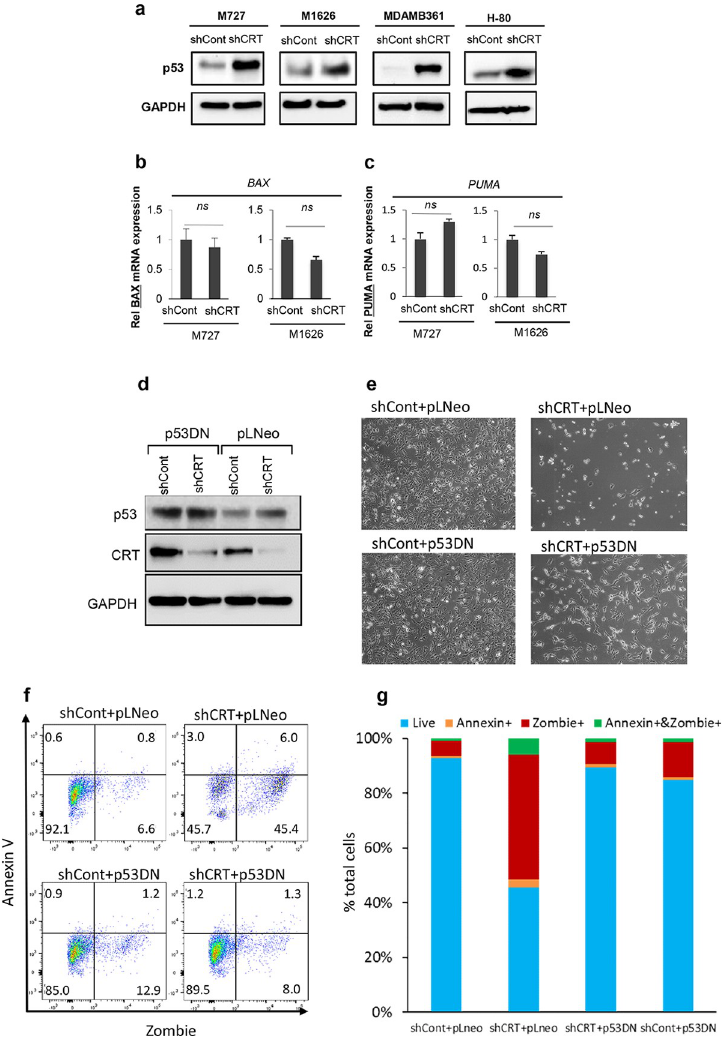
Fig 5. Activated p53 mediates cell death response during CRT down-regulation. (A) Western blot analysis of p53 protein levels in the indicated cell types transduced with shCont or shCRT. Quantification of p53 target genes (B) BAX and (C) PUMA using qRT-PCR and gene-specific primers; Y-axis represent relative fold change in 2 ddcT values of an indicated gene mRNA normalized to the control expression of 18 s rRNA. (D) Western blot analysis of p53 and CRT protein levels following transduction of the target cells with p53DN GSE56 pLNeo, shCRT, and shCont viral particles. (E) Representative images of the indicated cell populations demonstrating effects of p53 inhibition on the cell survival. (F, G) Flow cytometric analysis and quantification of the cell-death phenotype in the transduced cell populations using Zombie/Annexin V assay. Underlying source data can be found in S1 Data. CRT, calreticulin; GAPDH, Glyceraldehyde 3-phosphate dehydrogenase; MDAMB361, human breast adenocarcinoma cell line; pLNeo, lenti-viral plasmid expressing Neomycin R gene; qRT-PCR, Real-Time Quantitative Reverse Transcription PCR; shCont, short hairpin RNA targeting Control; shCRT, short hairpin RNA targeting